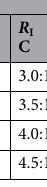
Table 2. Factors and levels of orthogonal experiment. Where T A is the activation temperature, t A is the activation time, R I is the impregnation